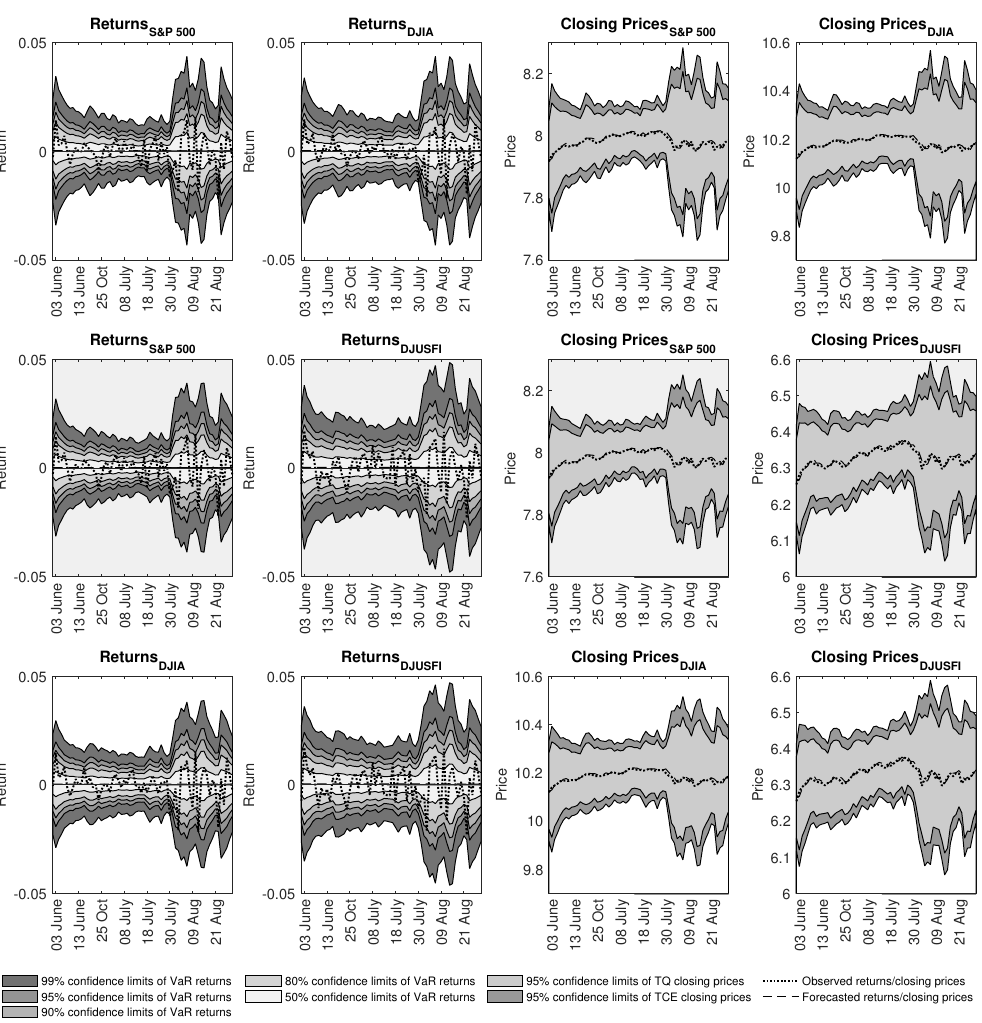
Figure 4. One-day-ahead VaR forecasts of returns (left 2 panels) and closing prices (right 2 panels) at varying levels for return series using two-stage MCARR-return model with S&P 500, DJIA and DJUSFI indices from 3 June 2019 to 30 August